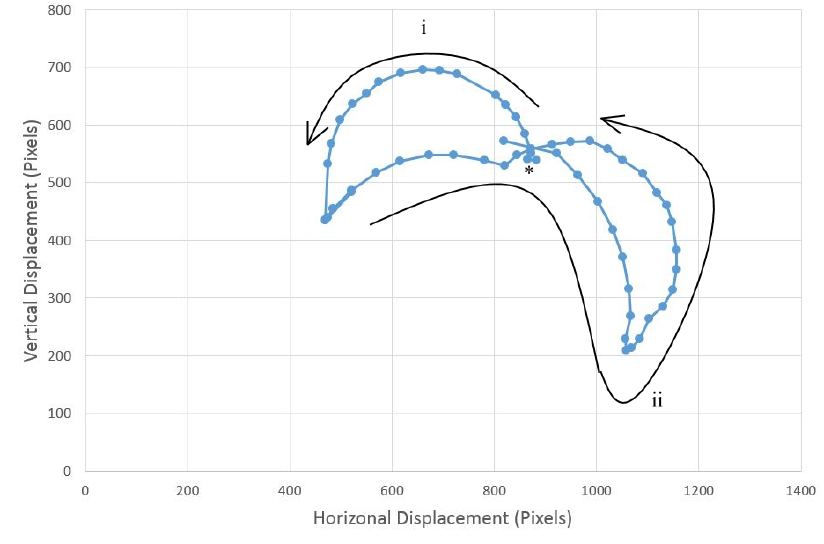
Figure 3. The full ciliary beat action performed by the artificial cilium. The power stroke (i) starts at the marked position (*), which progresses into the recovery stroke